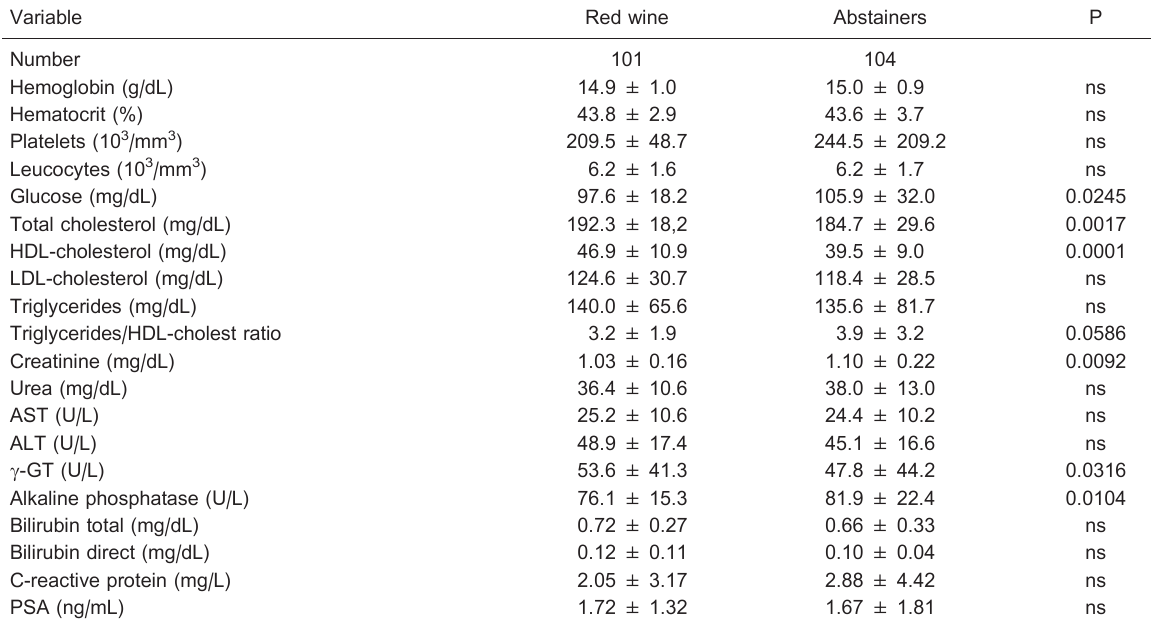
Table 3. Laboratory